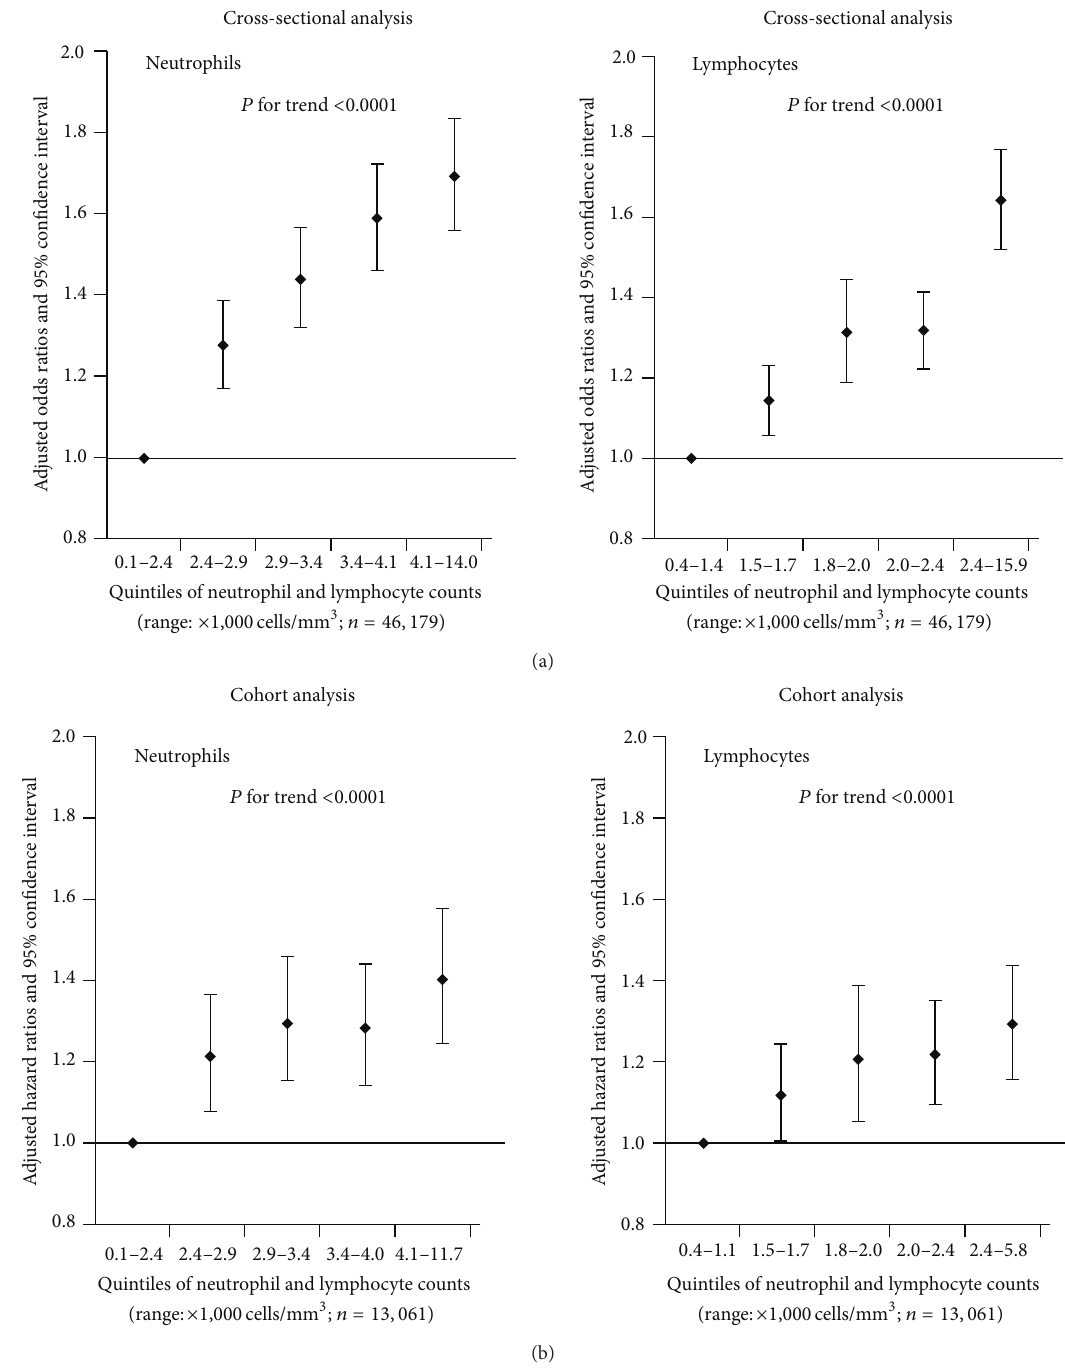
Figure 2: Adjusted odds ratios (a) and hazard ratios (b) (95% confidence interval) of the relationship between the quintiles of neutrophil and lymphocyte counts and metabolic syndrome. Adjusted for age, sex, BMI, smoking status, drinking status, and family history of cardiovascular disease, hypertension, hyperlipidemia, and